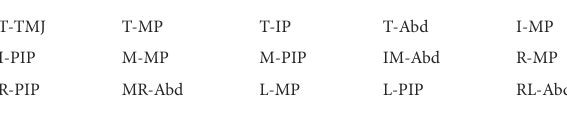
TABLE 1 Measured joint